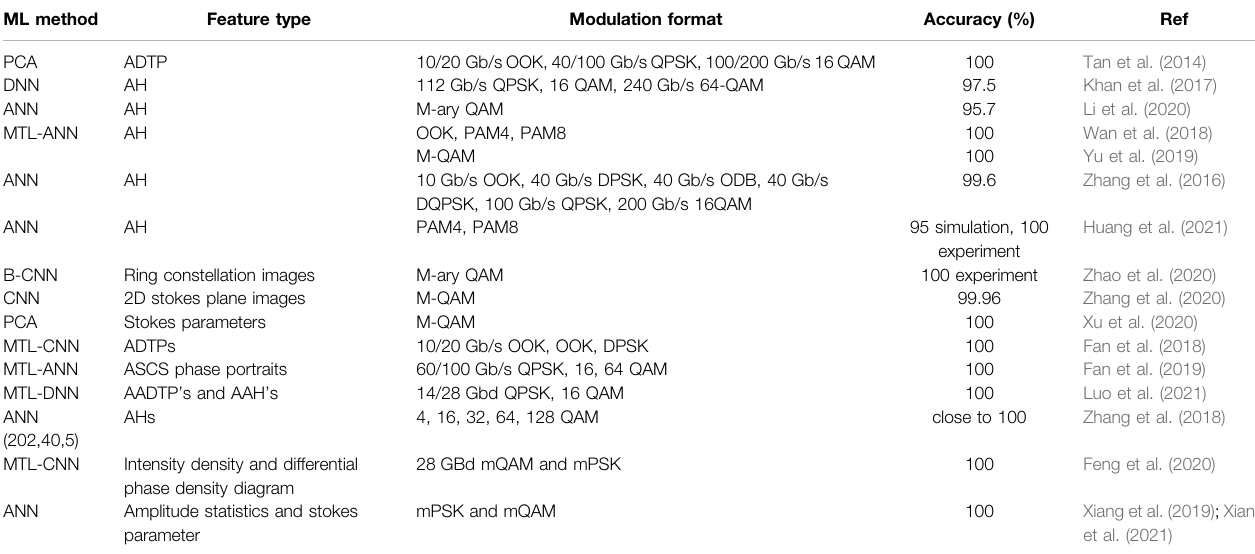
TABLE 5 | Summary of ML methods used for